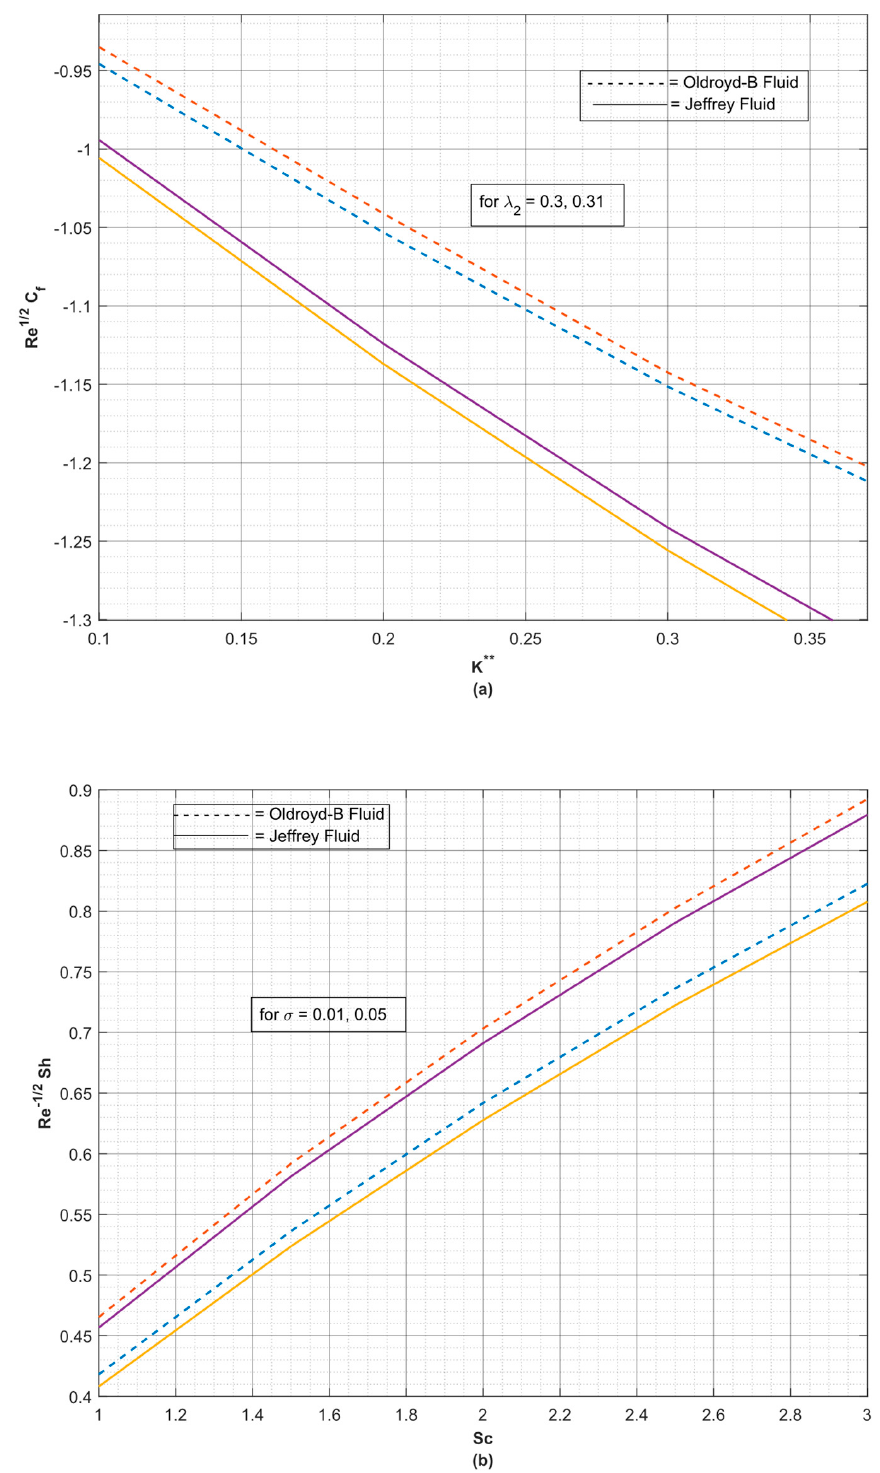
Figure 6. ( a ) Plot for skin friction, and ( b ) plot for Sherwood number.